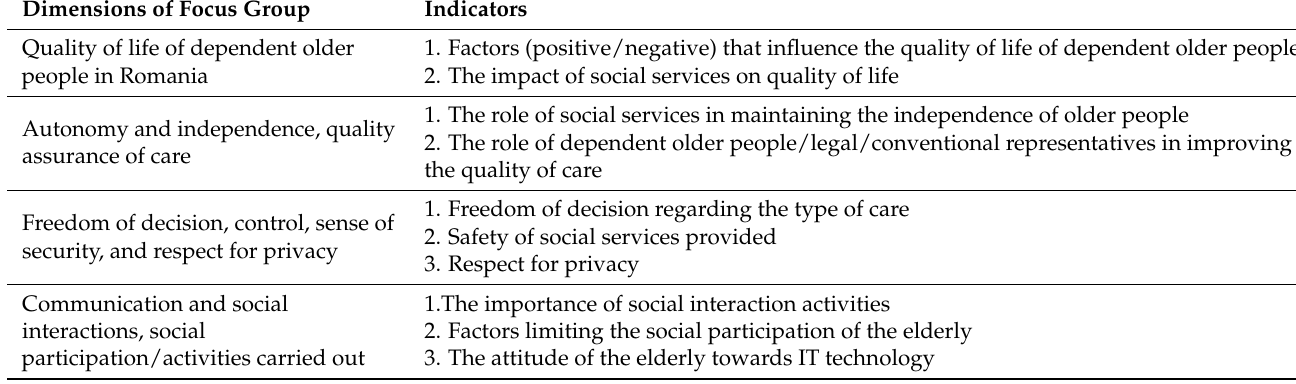
Table 1. Dimensions and indicators operationalized in the focus group guide.